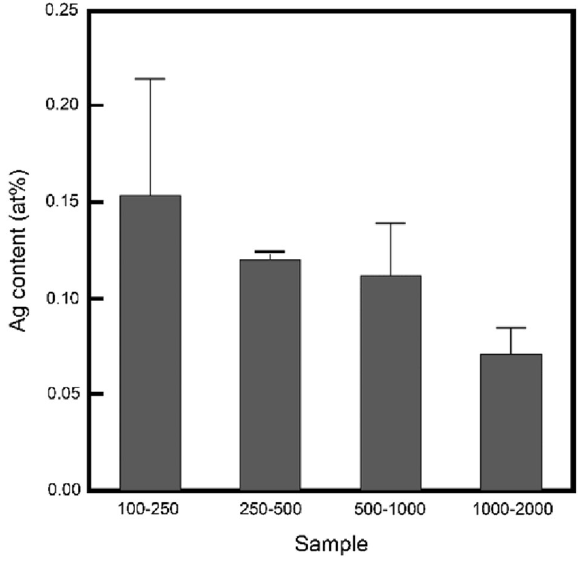
Fig. 4 Ag contents in OCP-Ag foams as a function of initial granule